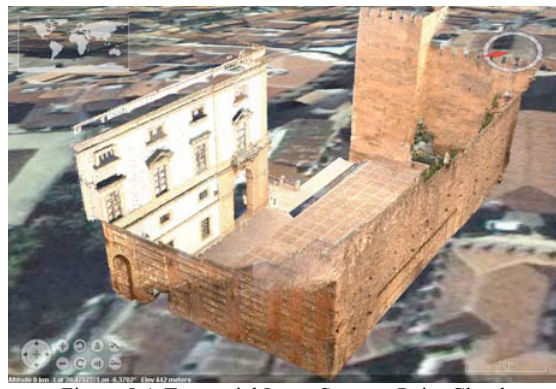
Figure 5 A Terrestrial Laser Scanner Point Cloud